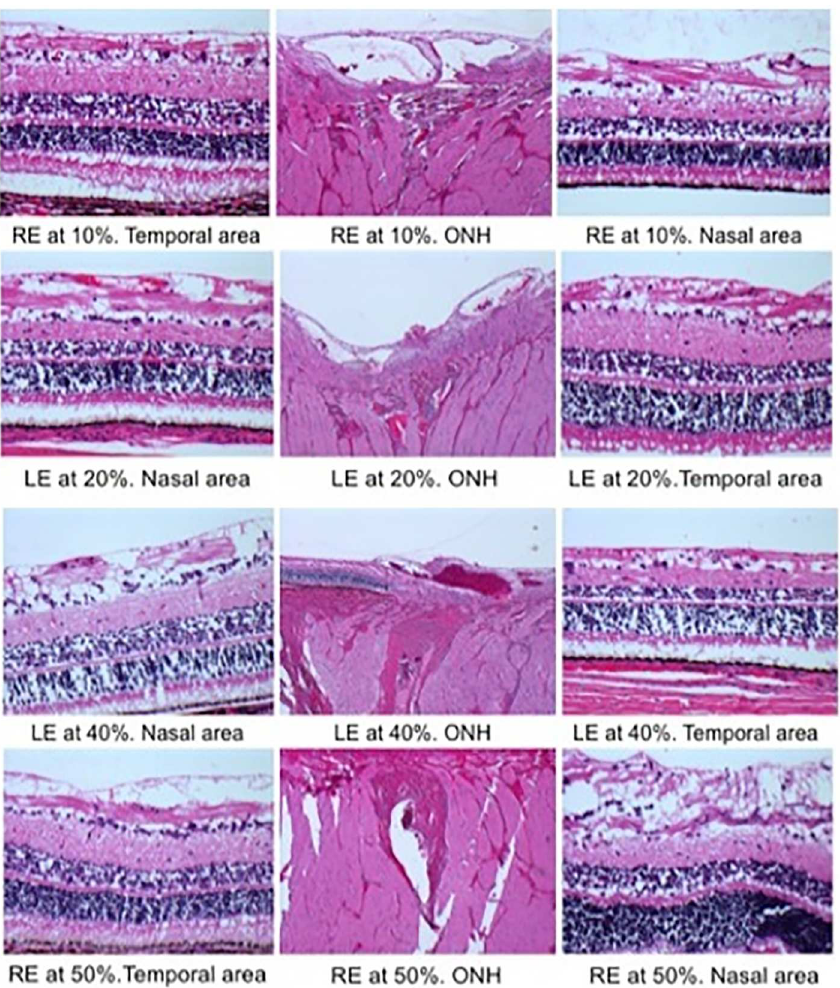
Fig 10. Hematoxylin-eosin stained horizontal sections in non-recovery anaesthesia live animal experiments. Hematoxylin-eosinstained horizontal sections through the optic nerve head and the areas nasal and temporal to the nerve head after pars plana vitrectomy using a hypersonicvitrector at 10%, 20%, 40%, or 50% ultrasoundpower. Vacuolization can be seen at all settings, as well as fragmentation of the nerve fibers and ganglioncell layers. The inner limitingmembrane showed separationwithout disruption. (RE = right eye; ONH = optic nerve head; LE = left eye).